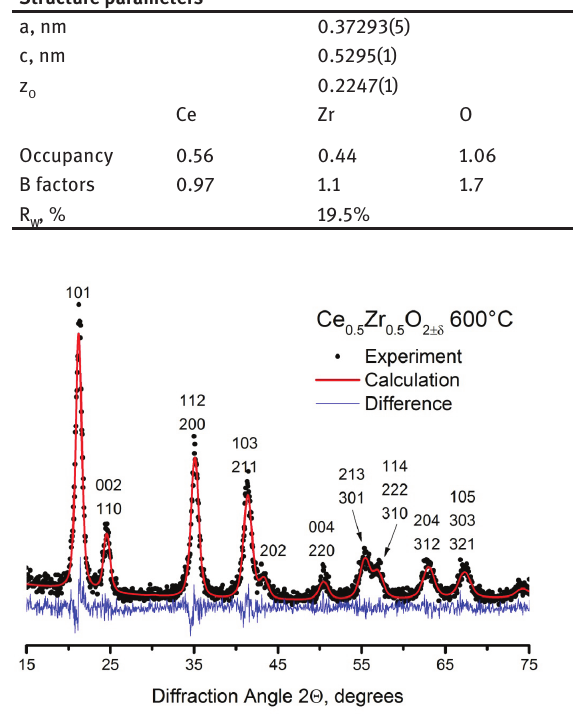
Figure 3: Experimental X-ray diffraction pattern (black points), its fitting (red solid line) and difference between experimental and calculated patterns (blue solid line) for Ce at 600°С.